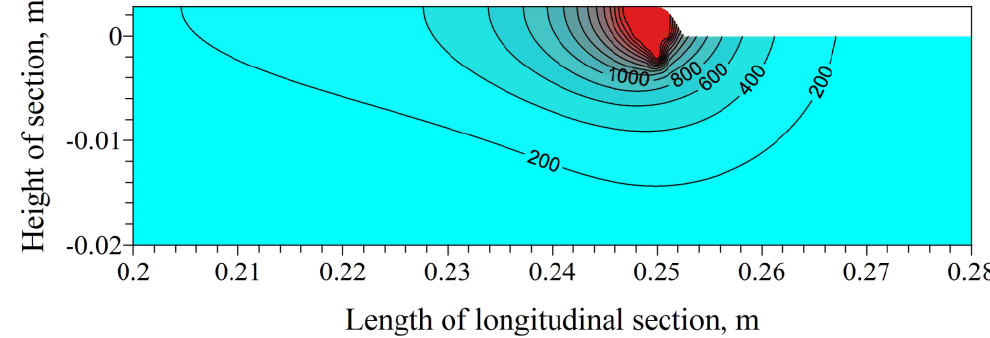
Figure 12. Temperature field (°C) in the longitudinal section on the axis of third weld ( y = 0.1 m) during application, at time t = 83 s (position of electrode x = 0.25 m).